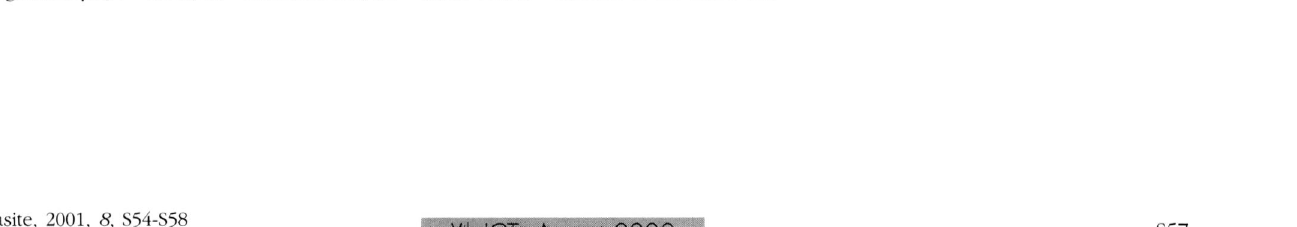
Fig. 4. - Trichinella pseudospiralis larvae in Swiss mouse muscles three months after infection. A) transmission electron micrograph (TEM) of a recently infected host muscle cell with the texture of the cell still partially conserved (x 20,000); B and C) TEM showing the disgre- gation of myofilaments and the concentration of mitochondria closed to the larval surface. The inner matrix of mitochondria is partially vacuolated (x 5,500); D) TEM of the nurse cell characterised by an elaborated system of the endoplasmic reticulum and cisternae (x 21,000). G = granulocyte. 1 = larva, m = mitochondria, nc = nurse cell, n = nucleus of the nurse cell.